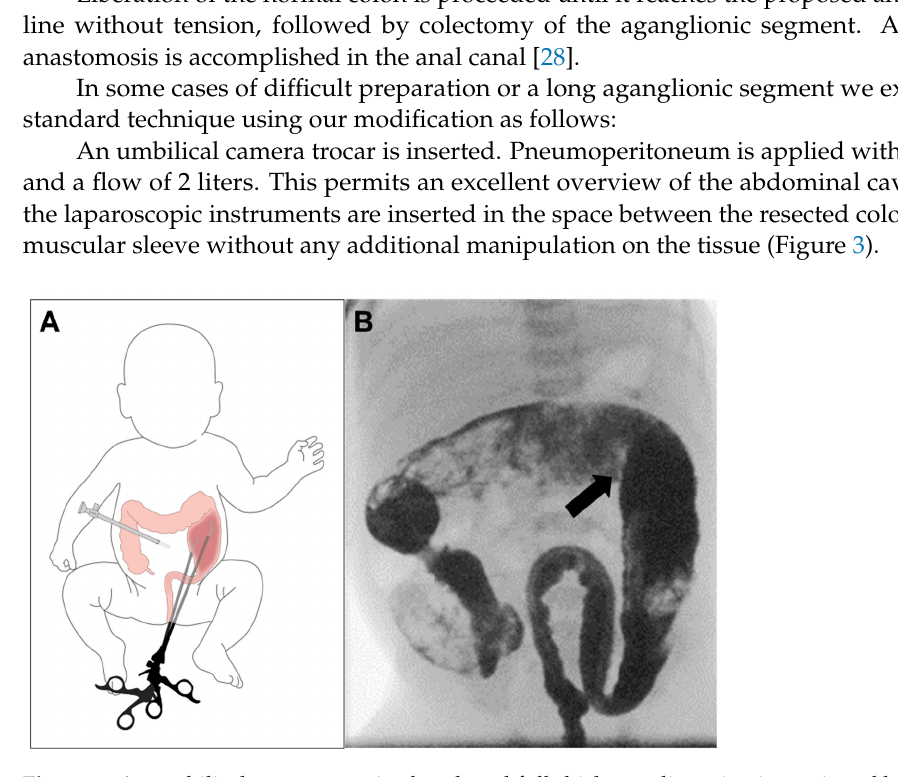
Figure 3. An umbilical camera port is placed, and full-thickness dissection is continued by transanal instrumentation entering the transition zone ( A ). The preoperative abdominal X-ray shows the transition zone (arrow) at the left colonic flexure ( B